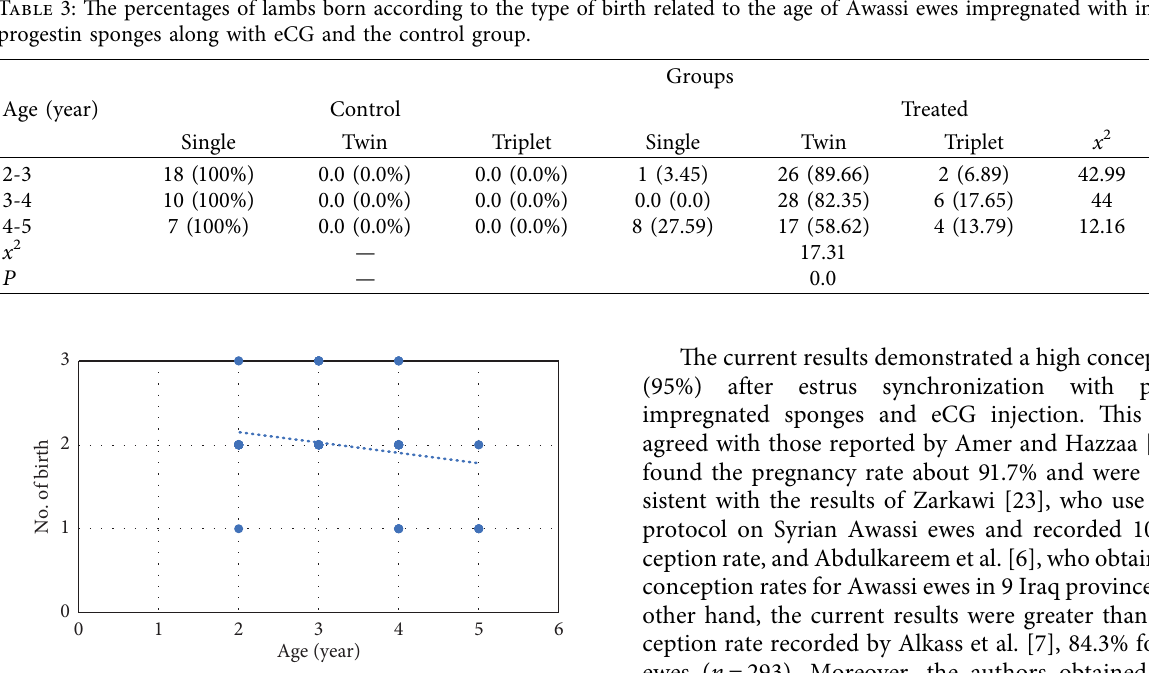
Figure 1: Relationship between age of Awassi ewes and type of birth of ewes impregnated with intravaginal progestin sponges along with eCG. R �− 0.224 (no signifcant